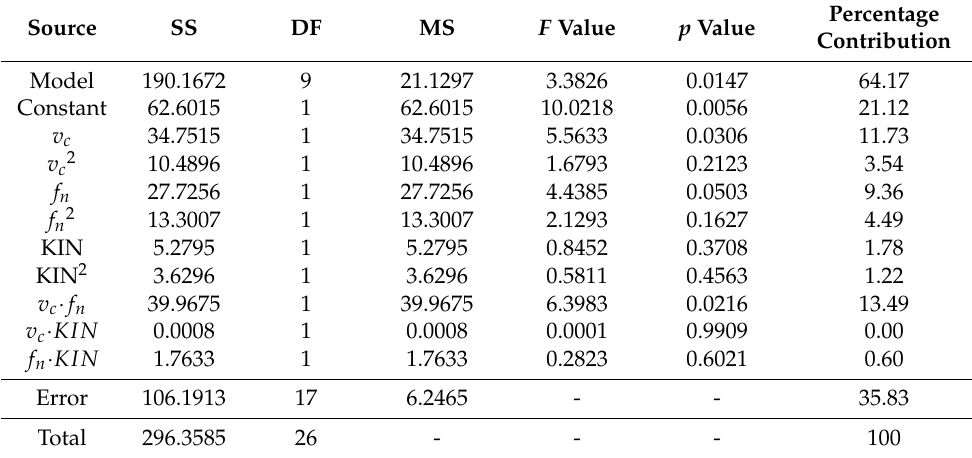
Table 7. ANOVA results for the straightness error.